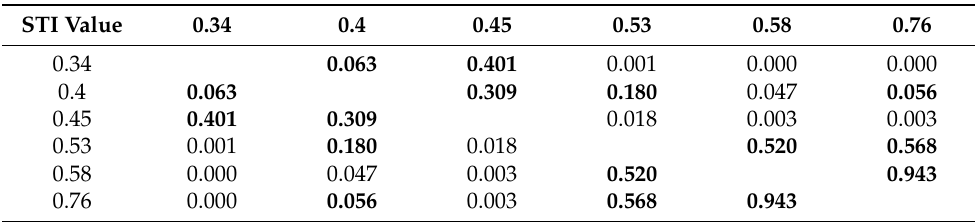
Table 4. Matrix of p -values obtained after carrying out Dunn’s post hoc test for the minimum RoS, for which utterances presented to the experiment participants were unintelligible. Statistically insignificant values are marked in bold.